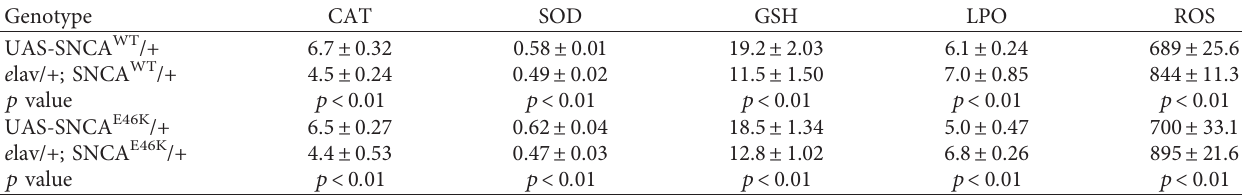
Table 1: Overexpression of human SNCA leads to oxidative